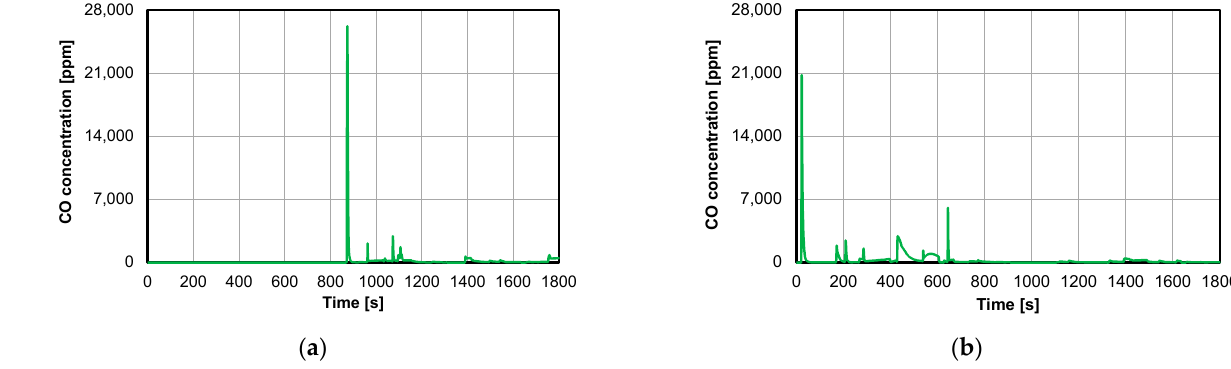
Figure 11. The CO concentration versus time for: ( a ) plug-in; ( b ) HEV.